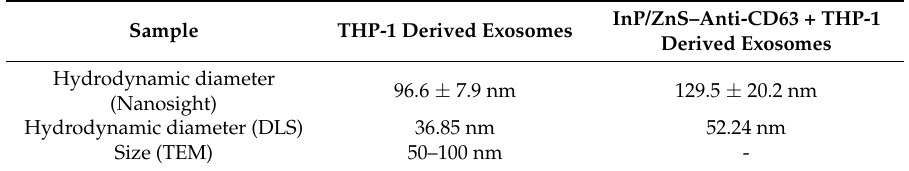
Table 2. Size results for the THP-1 derived exosomes and a mix of InP/ZnS–Anti-CD63 + THP-1 derived exosomes. The mix was incubated together in a fridge for an hour.